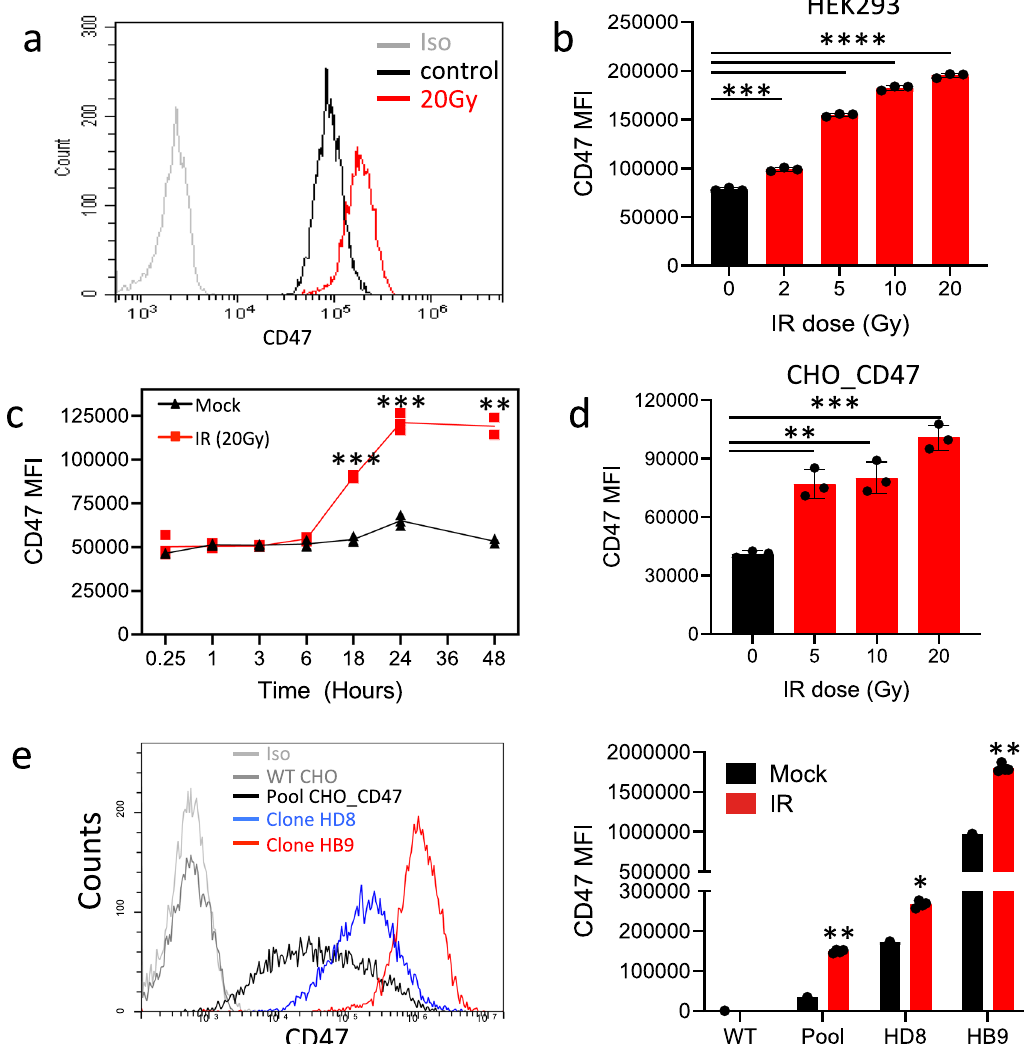
Fig. 1 γ -irradiation induces CD47 overexpression. a Representative histogram of CD47 staining and fl ow cytometric analysis before and after γ -irradiation (HEK-293T cells). b Dose-dependent expression of CD47 (MFI) in HEK-293T cells 24 h after γ -irradiation. c Time-dependent expression of CD47 (MFI) in HEK-293T cells following 20Gy γ -irradiation. d CD47 expression (MFI) in CHO cells transfected with human CD47 24 h after γ -irradiation. e Representative histogram of CD47 staining of CHO_CD47 of different clones (left panel) and their corresponding CD47 expression (MFI) in response to 20 Gy γ -irradiation (right panel). Graphs show an average (±STD) of four replicates in each group. One of at least four independent experiments is shown. * p < 0.05; ** p < 0.005; *** p <